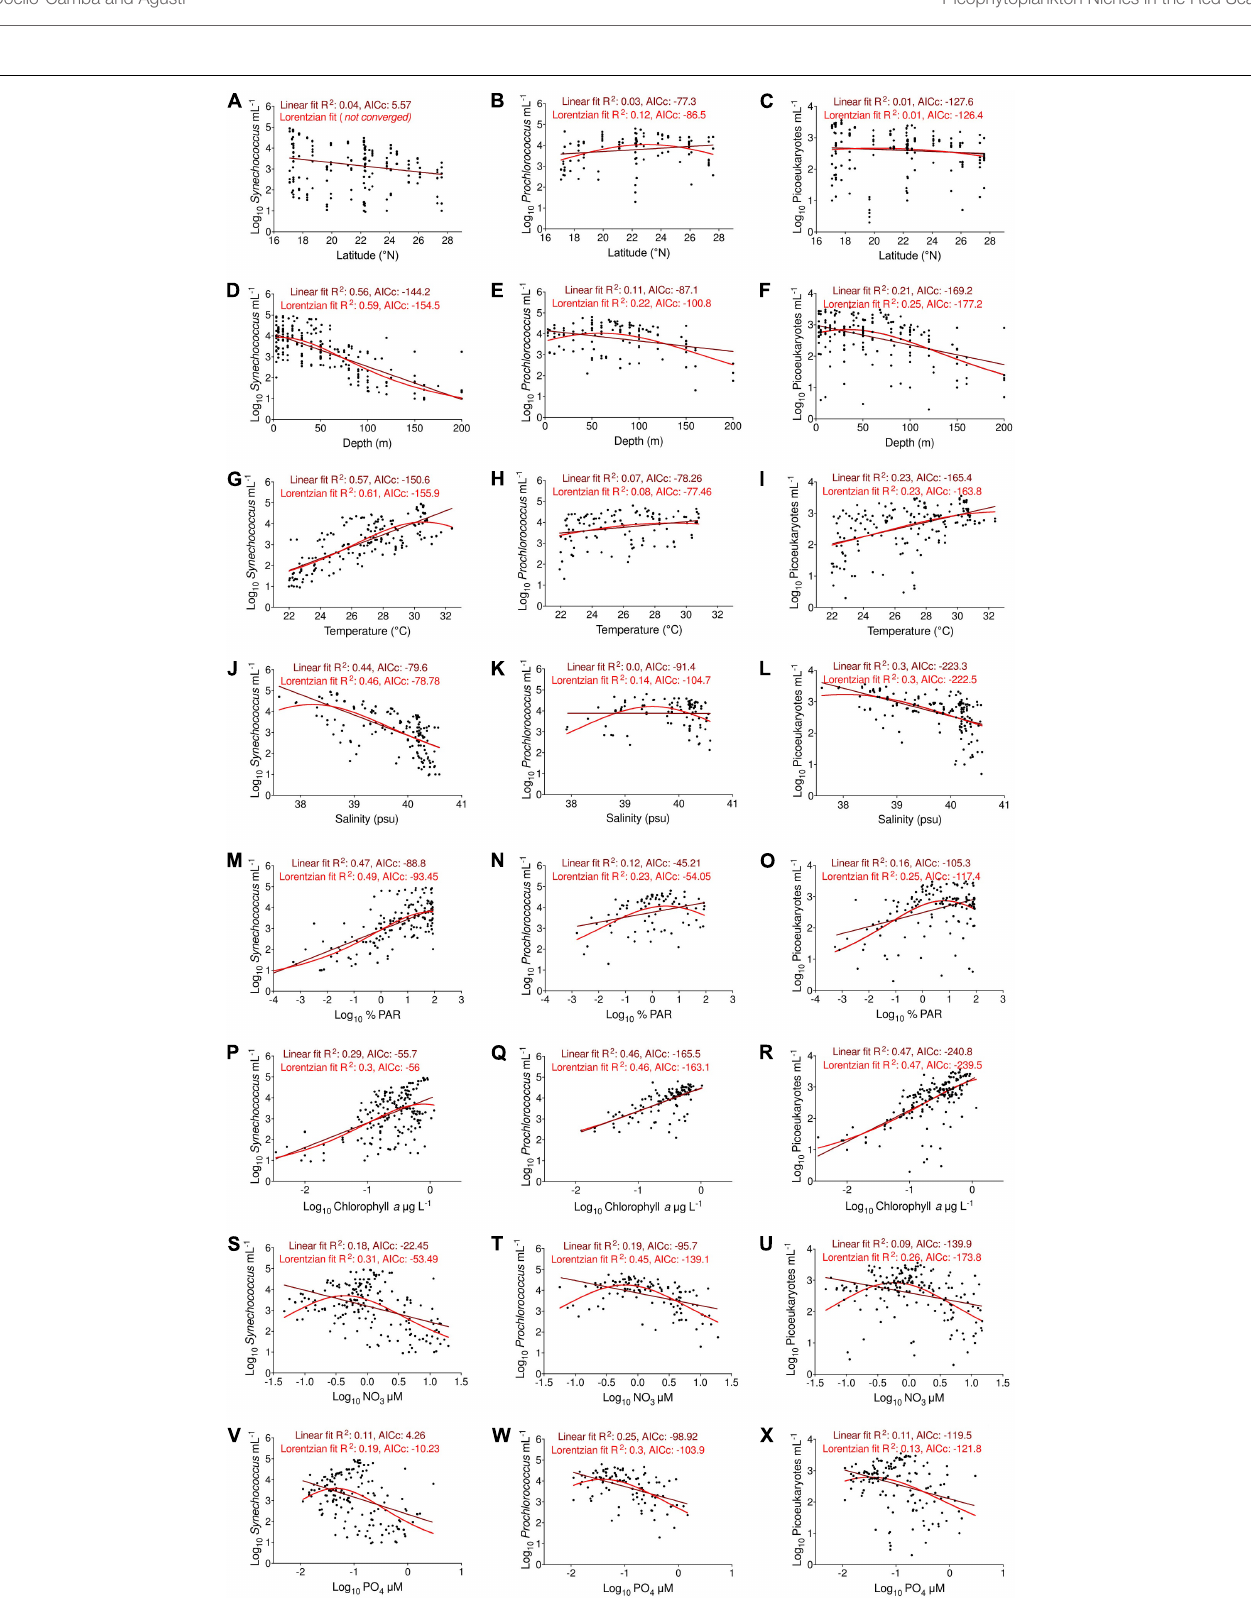
Frontiers in Marine Science |